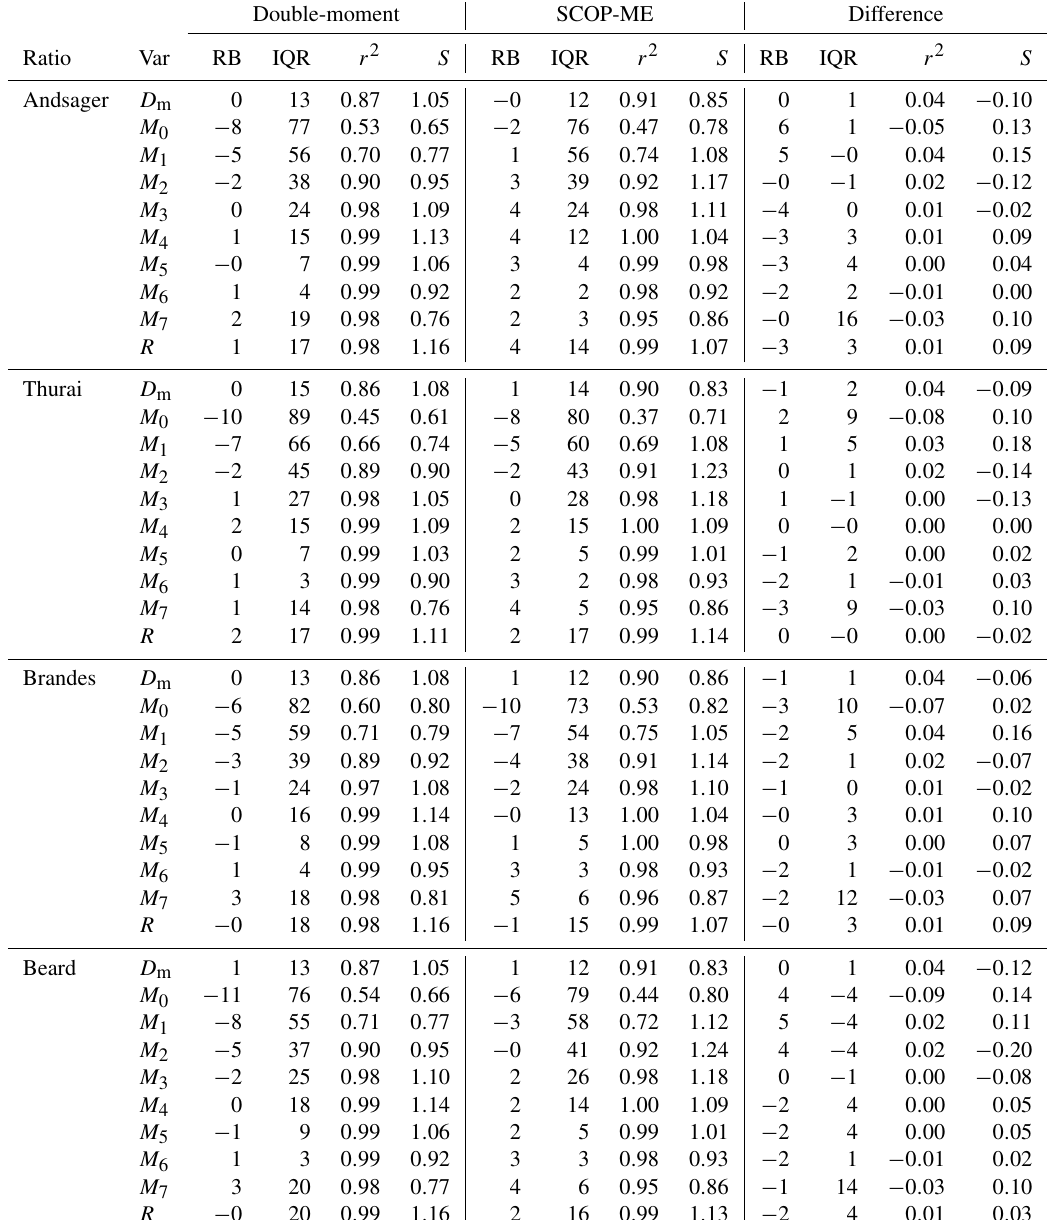
Table A3. Comparison of double-moment method to SCOP-ME results on all Parsivel data in the Iowa data set by axis ratio function (Ratio). Columns are as for Table